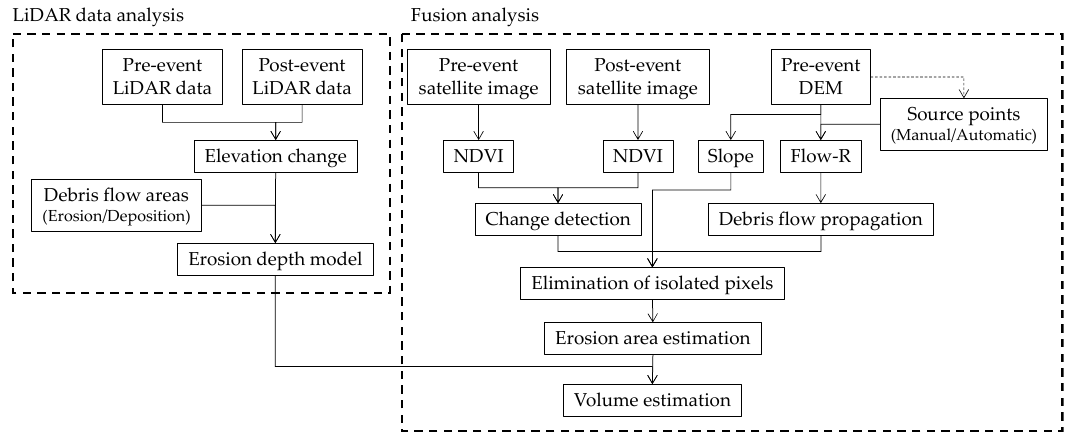
Figure 3 . Flow of LiDAR data analysis and fusion analysis of optical satellite images and DEM.